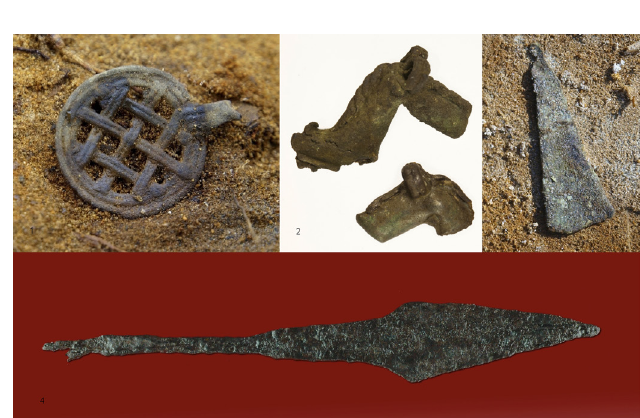
Figure 4. Finds from Brodtkorbneset and Steintjørna 1. Bronze orna- ment, photo Bjørnar Olsen; 2. Bronze horse head fragments, photo Bjørn Hatteng; 3. Axe shaped pendant (copper), photo Bjørnar Olsen; 4. Iron arrowhead, photo Tromsø